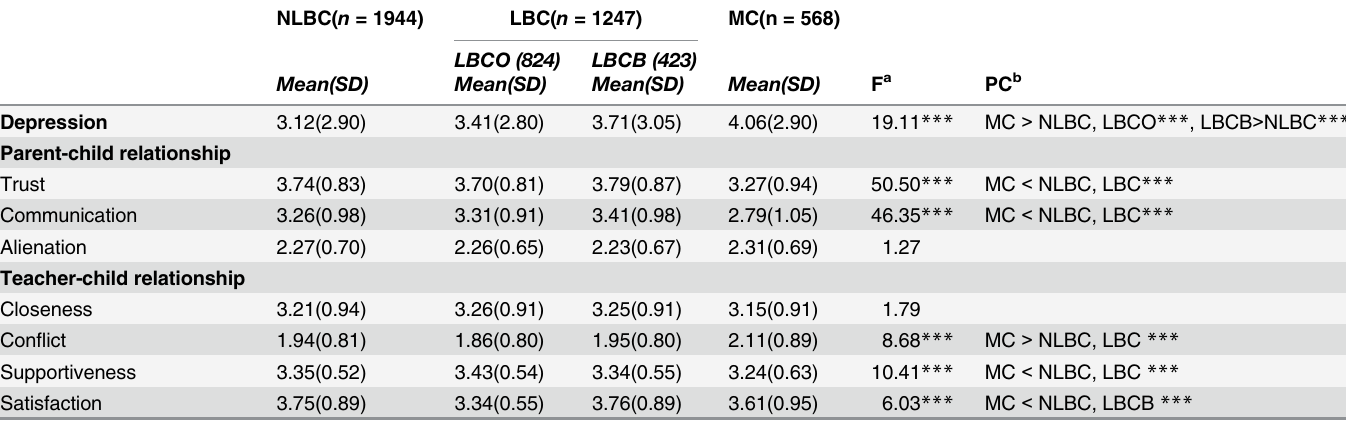
Table 2. Comparisons among NLBC, LBC and MC regarding depression and quality of interpersonal relationships (N = 3759). NLBC( n = 1944)